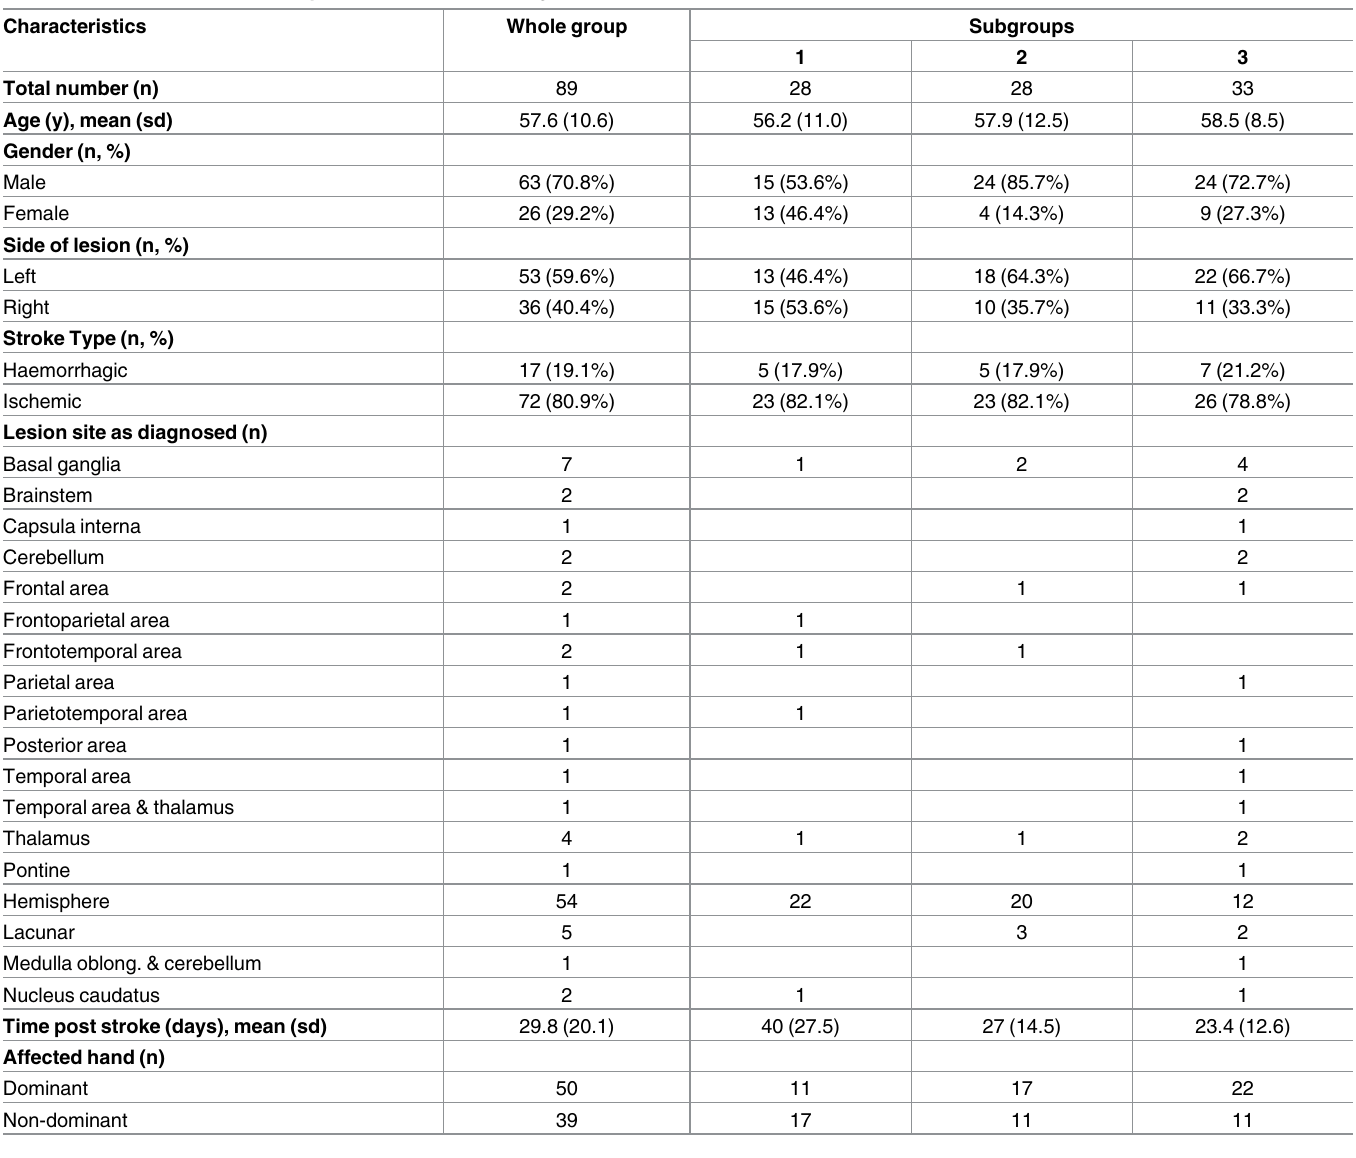
Table 1. Patient characteristics upon inclusion in the